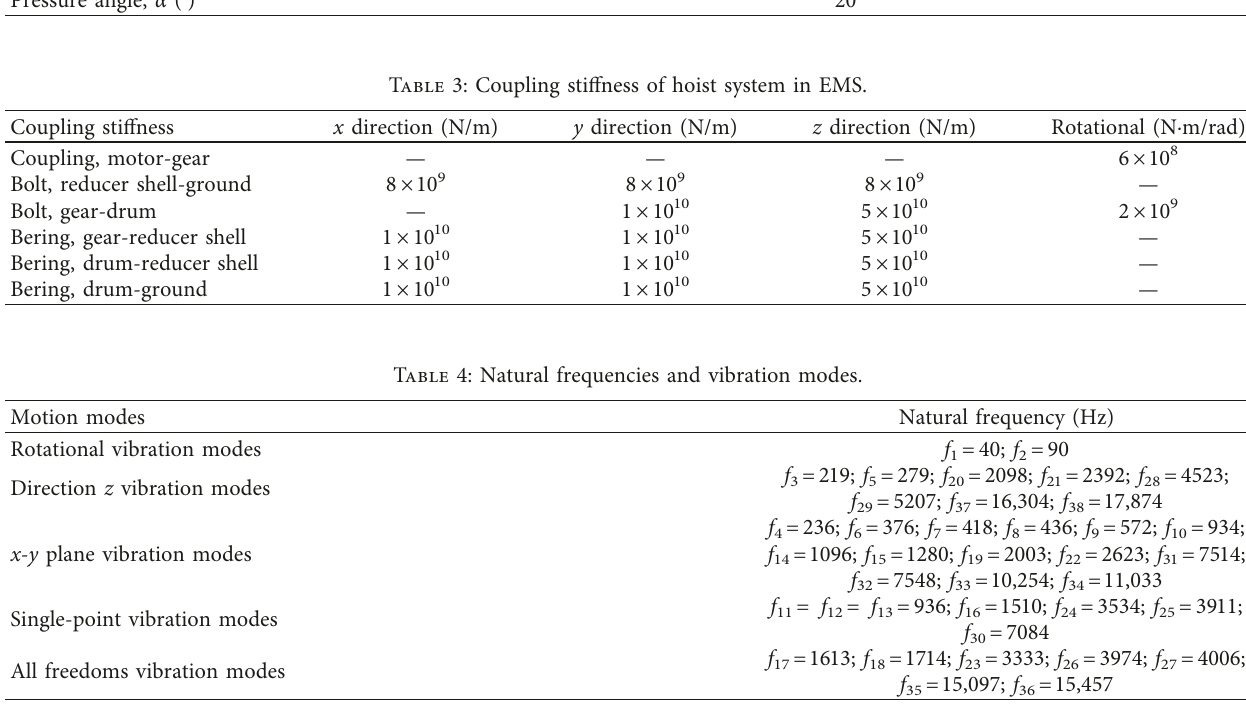
torque are 147.6 Hz and 297.5 Hz, marked as f Figure 11(c). Between 2nd and 5th order natural frequency, the ripple torque may cause system resonance.